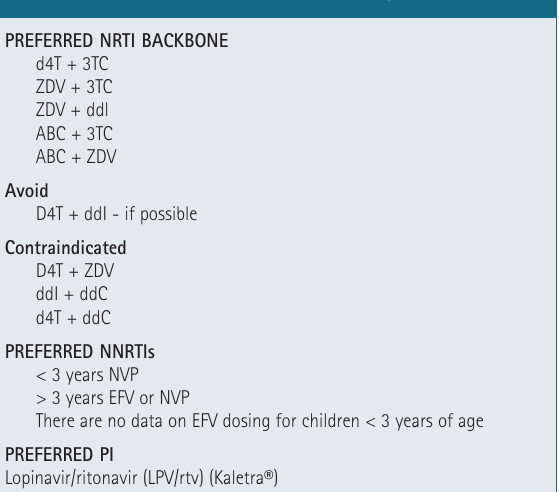
TABLE V. PREFERRED ARVs